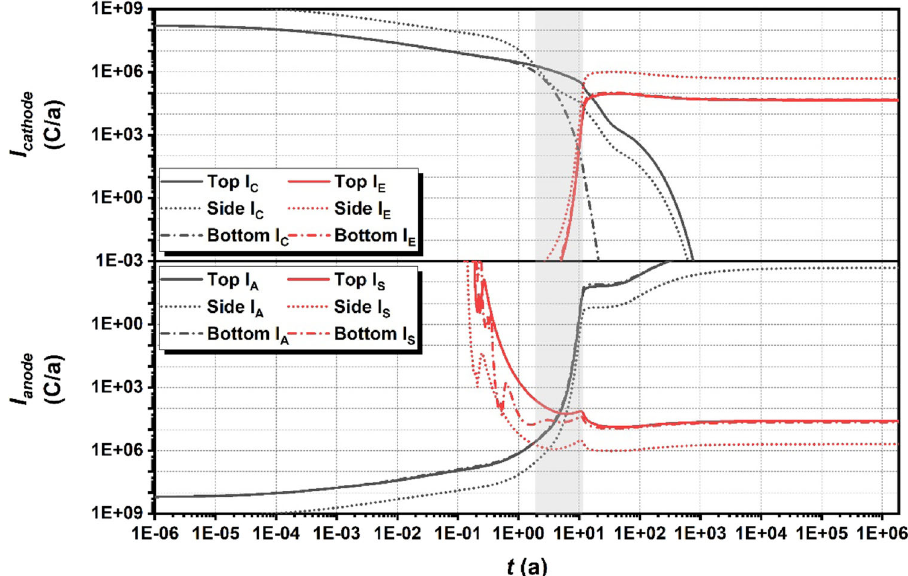
Fig. 13 Cathodic ( I cathode ) and anodic ( I anode ) current densities for corrosion of copper top, side, and bottom surfaces. i A : anodic current density for anodic dissolution of Cu with Cl − ; i S : anodic current density for Cu sul fi dation; i C : cathodic current density for O 2 reduction; i E : cathodic current density for H 2 O reduction with HS − .